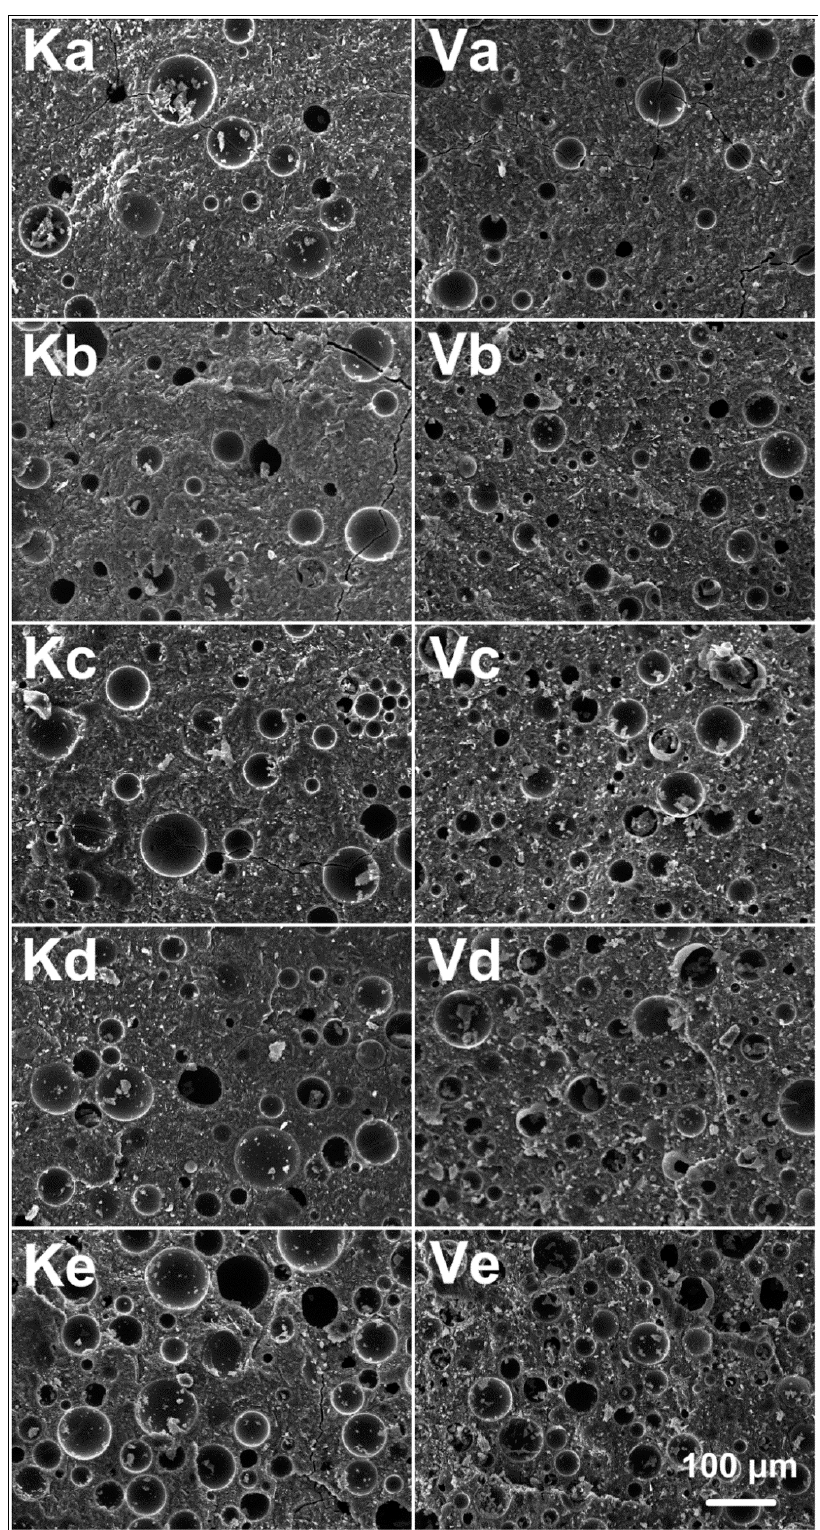
Figure 4. Internal morphologies of alkali activated metakaolin-based geopolymers with different ratios of HMGB: Ka–Ke denote the volume ratios of metakaolin to HMGB K1 of 10:1, 8:1, 6:1, 4:1 and 2:1, respectively; Va–Ve denote the volume ratios of metakaolin to HMGB VS-5500 of 10:1, 8:1, 6:1, 4:1 and 2:1, respectively. Scale bar indicates 100 μ m.